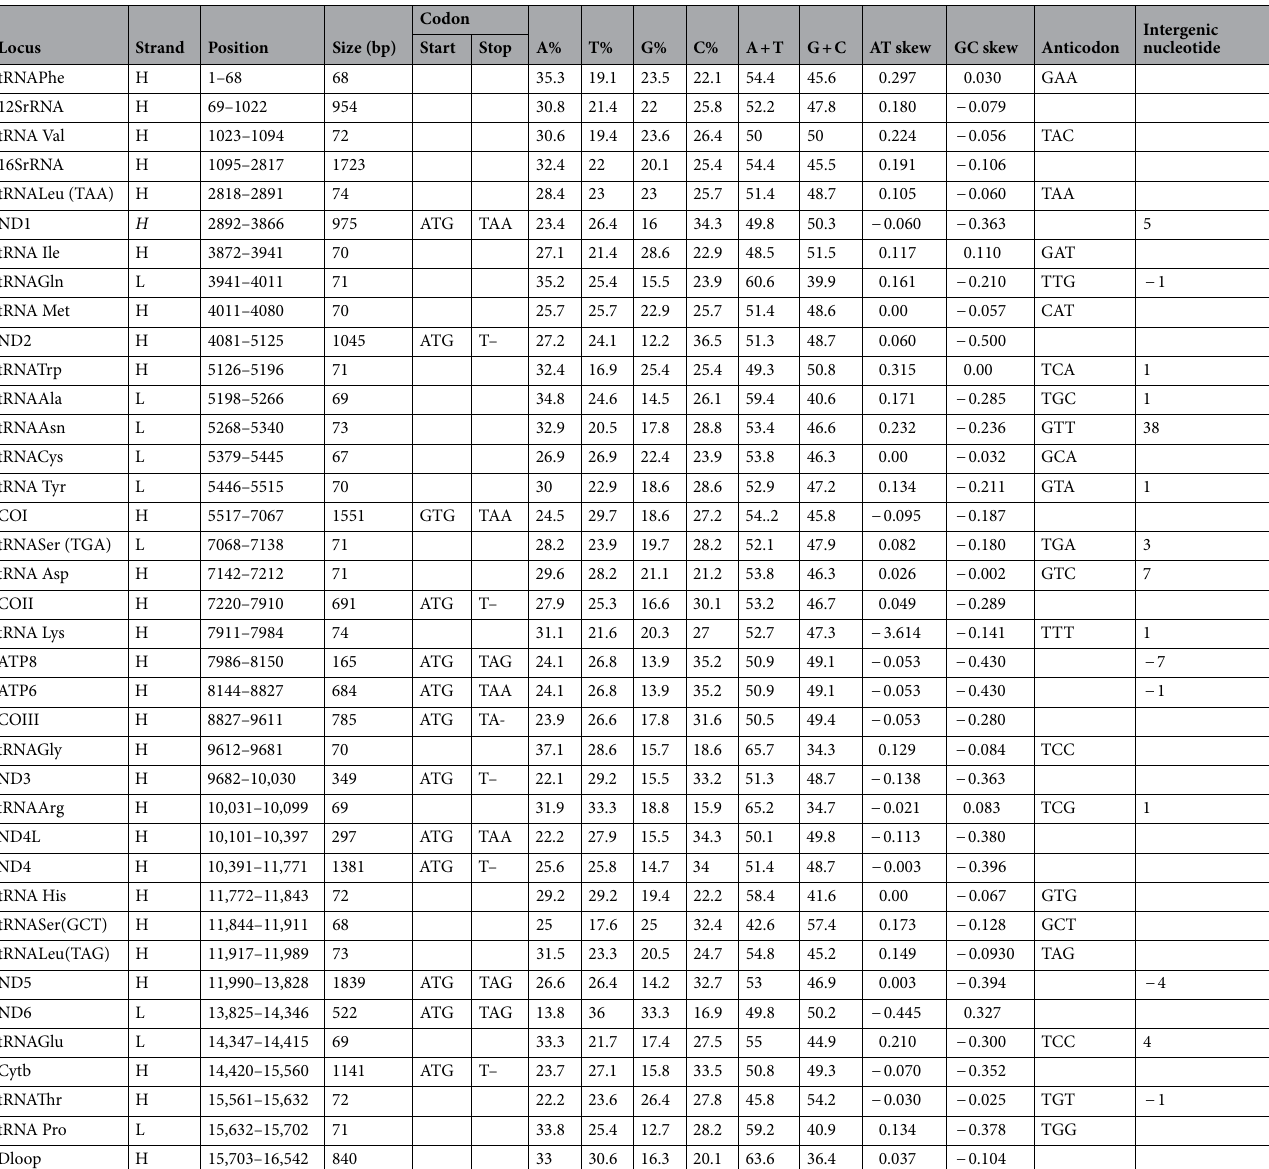
Table 1. Sequence characteristics of Decapterus russelli mitochondrial